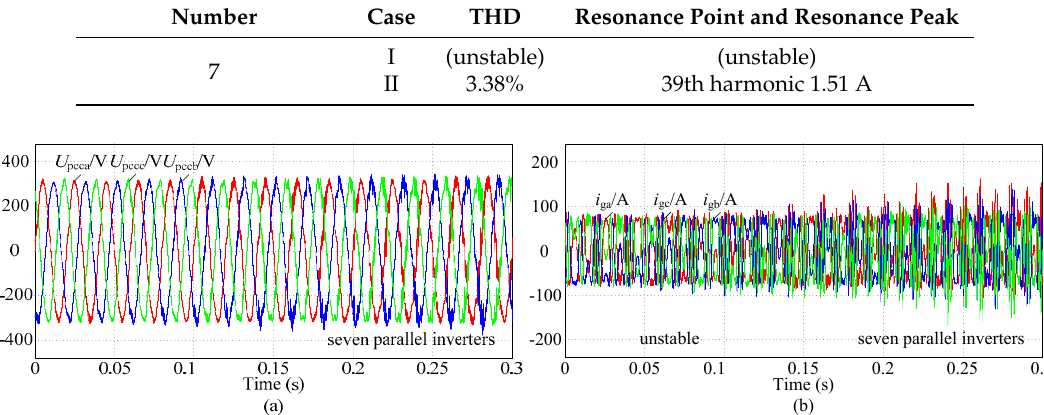
Figure 13. Simulation waveforms of PCC voltage u PCC and the grid-connected current i g in case II during reference current transient (two parallel inverters). ( a ) PCC voltage u PCC ; ( b ) grid-connected current i g ; ( c ) grid-connected current i g (before); ( d ) spectrogram of grid-connected current i g (before); ( e ) grid-connected current i g (after); ( f ) spectrogram of grid-connected current i g (after). Table 4. Simulation results of grid-connected current with seven parallel inverters.